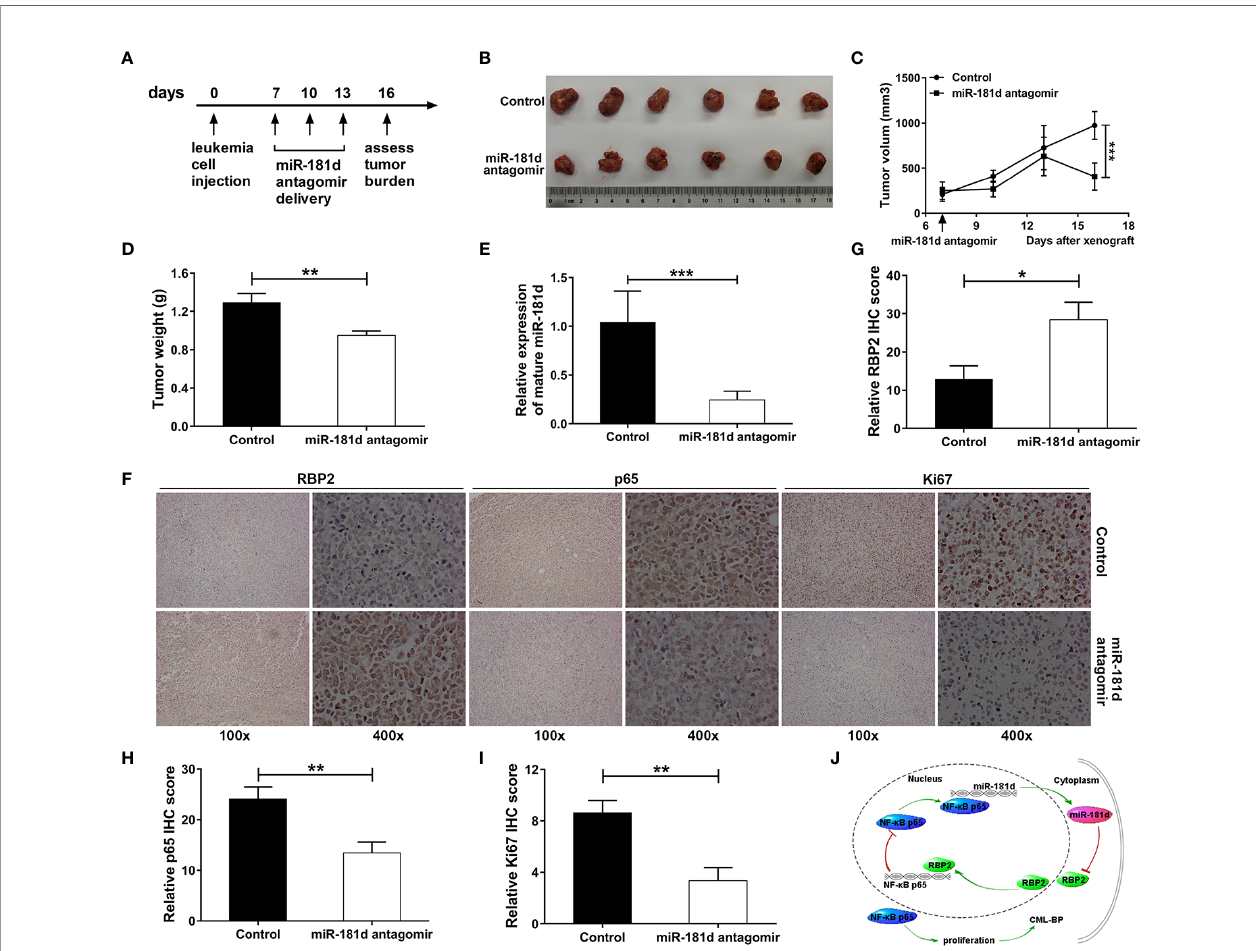
FIGURE 6 | Inhibition of miR-181d suppresses leukemia cell proliferation in vivo. (A) Xenograft model in NOD/SCID male mice. Timeline of the miR-181d antagomir therapeutic delivery experiment. Primary tumor gross appearance (B) and tumor growth curves (C) and the average tumor weight (D) of the miR-181d antagomir or control treated xenograft model. (E) RT – PCR analysis shows miR-181d antagomir ef fi cacy in each group. (F – I) IHC staining and relative IHC score for RBP2, p65 and Ki67 were performed on the indicated tumors. Similar results were acquired in three independent experiments. (J) A summary of the fi ndings. A new epigenetic mechanism involved in the pathogenesis of CML-BP: In CML progression, miR-181d overexpression directly inhibits RBP2 expression, low levels of RBP2 cannot repress the expression of p65, which increases miR-181d expression and stimulates cell proliferation. * p < 0.05, ** p < 0.01, *** p <